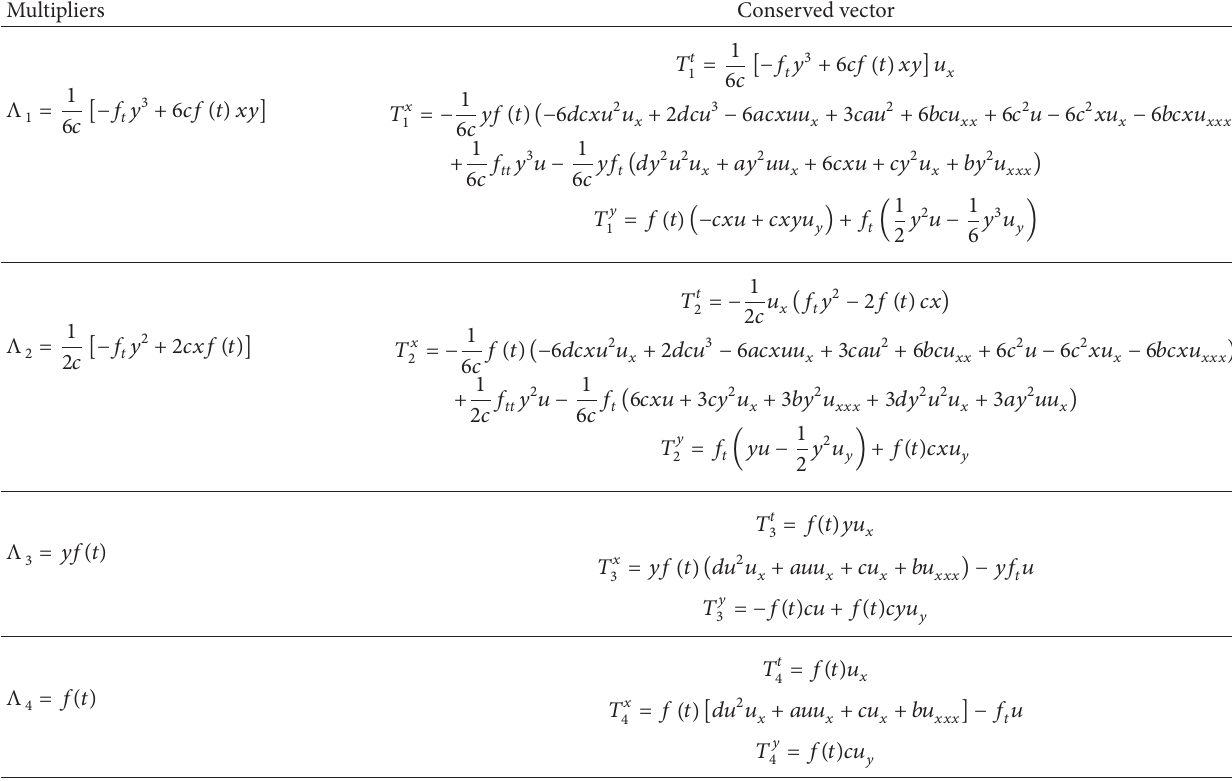
Table 3: Multipliers and conserved vectors for